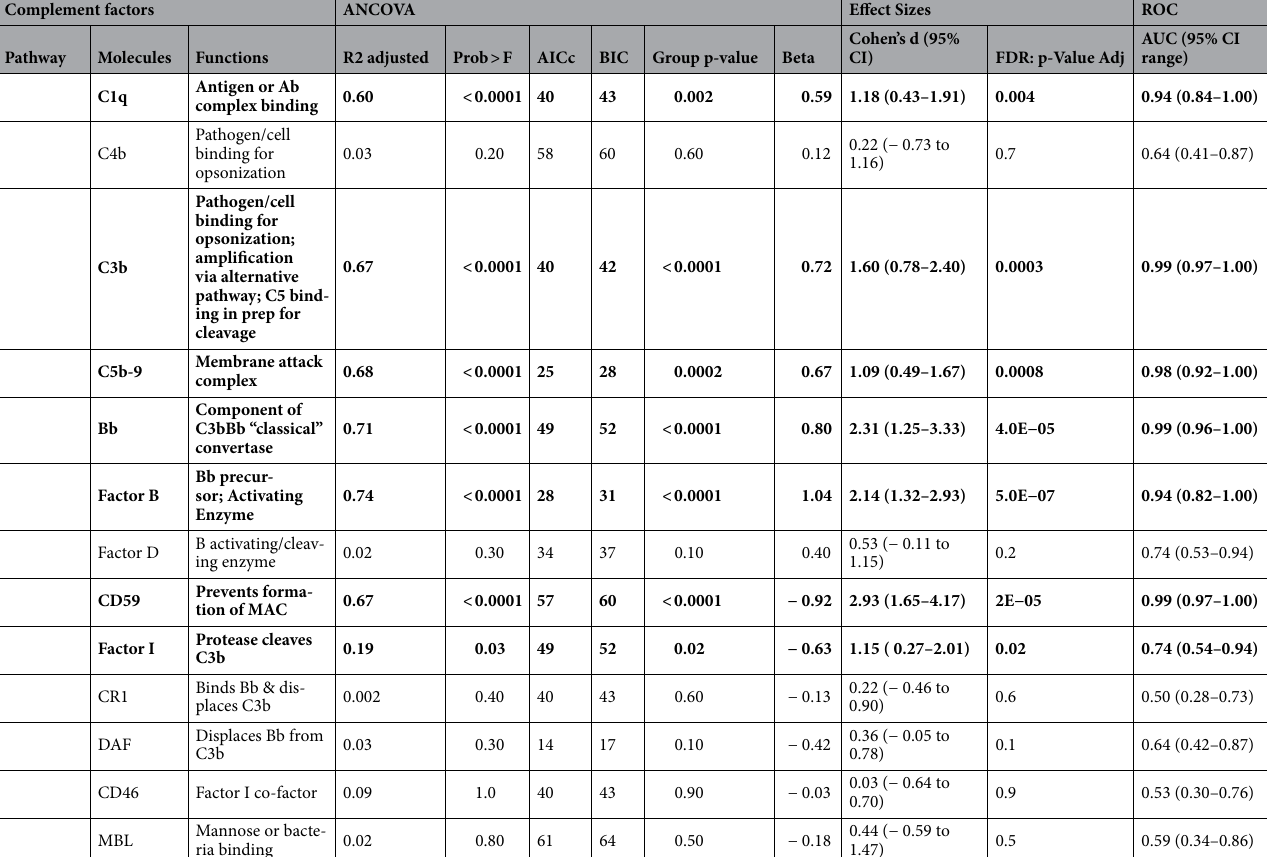
Table 2. Comparison of EDE complement factor concentrations between groups. This table includes a list of complement factors within pathways and respective functions, and results from statistical models: ANCOVA adjusted for age; Effect sizes (Cohen’s d) based on standard least square models; AUC based from ROC analyses. Statistically significant values are highlighted in bold. For ANCOVA, only statistically significant results are provided. P values are rounded to one non-zero digit. R 2 adjusted for age; CI confidence